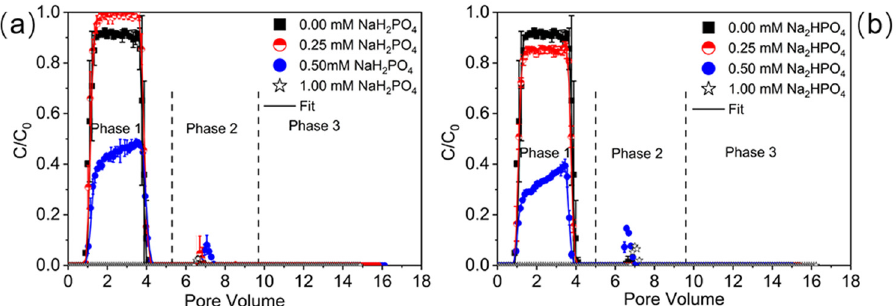
Figure 1. Breakthrough curves of PNPs at various NaH 2 PO 4 (0–1 mM) ( a ) or Na 2 HPO 4 ( b ) concentrations in the absence of NaCl under pH 7. The release of PNPs was initiated by eluting with ultrapure water under pH 7 (phase 2) and pH 10 (phase 3). Replicate experiments were performed under all experimental conditions. Table 1. Experimental parameters and the mass recoveries of PNPs under various experimental conditions.